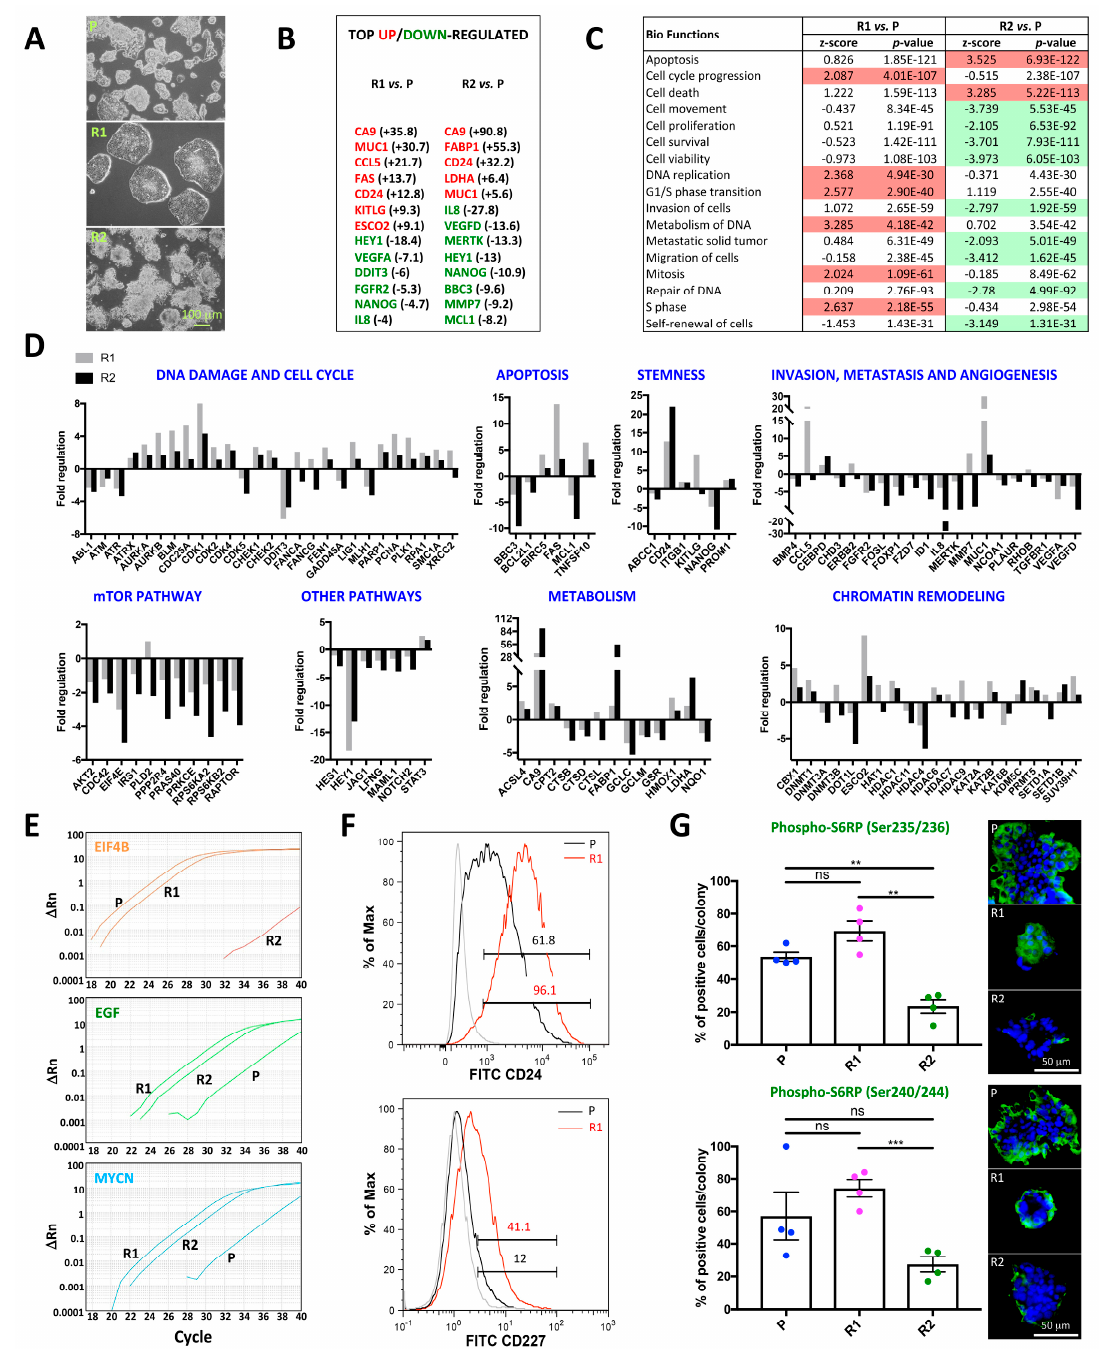
Figure 3. Differential morphology, gene expression profiles and biological functions in 5-FU resistant Tu42 colorectal cancer (CRC) stem-like cells as compared to parental cells. ( A ) Phase contrast images of parental (P) or 5-FU resistant Tu42 cells selected over an 8-month period